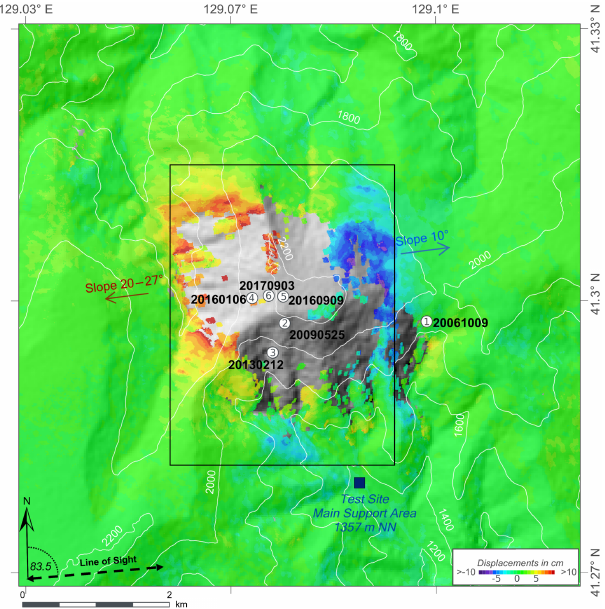
Figure 13. Surface displacements from DInSAR analysis for the 2017 North Korean nuclear test in September 2017. Coherence threshold is set to 0.25. Data from the days 29 August and from 12 September 2017 are used. Arrows indicate slope direction and angle. Numbered circles indicate the epicenters of the tests from 2006 to 2017. Black solid box delineates an area of around 3 × 4km 2 in which the surface displacement is between − 10 and 10cm.